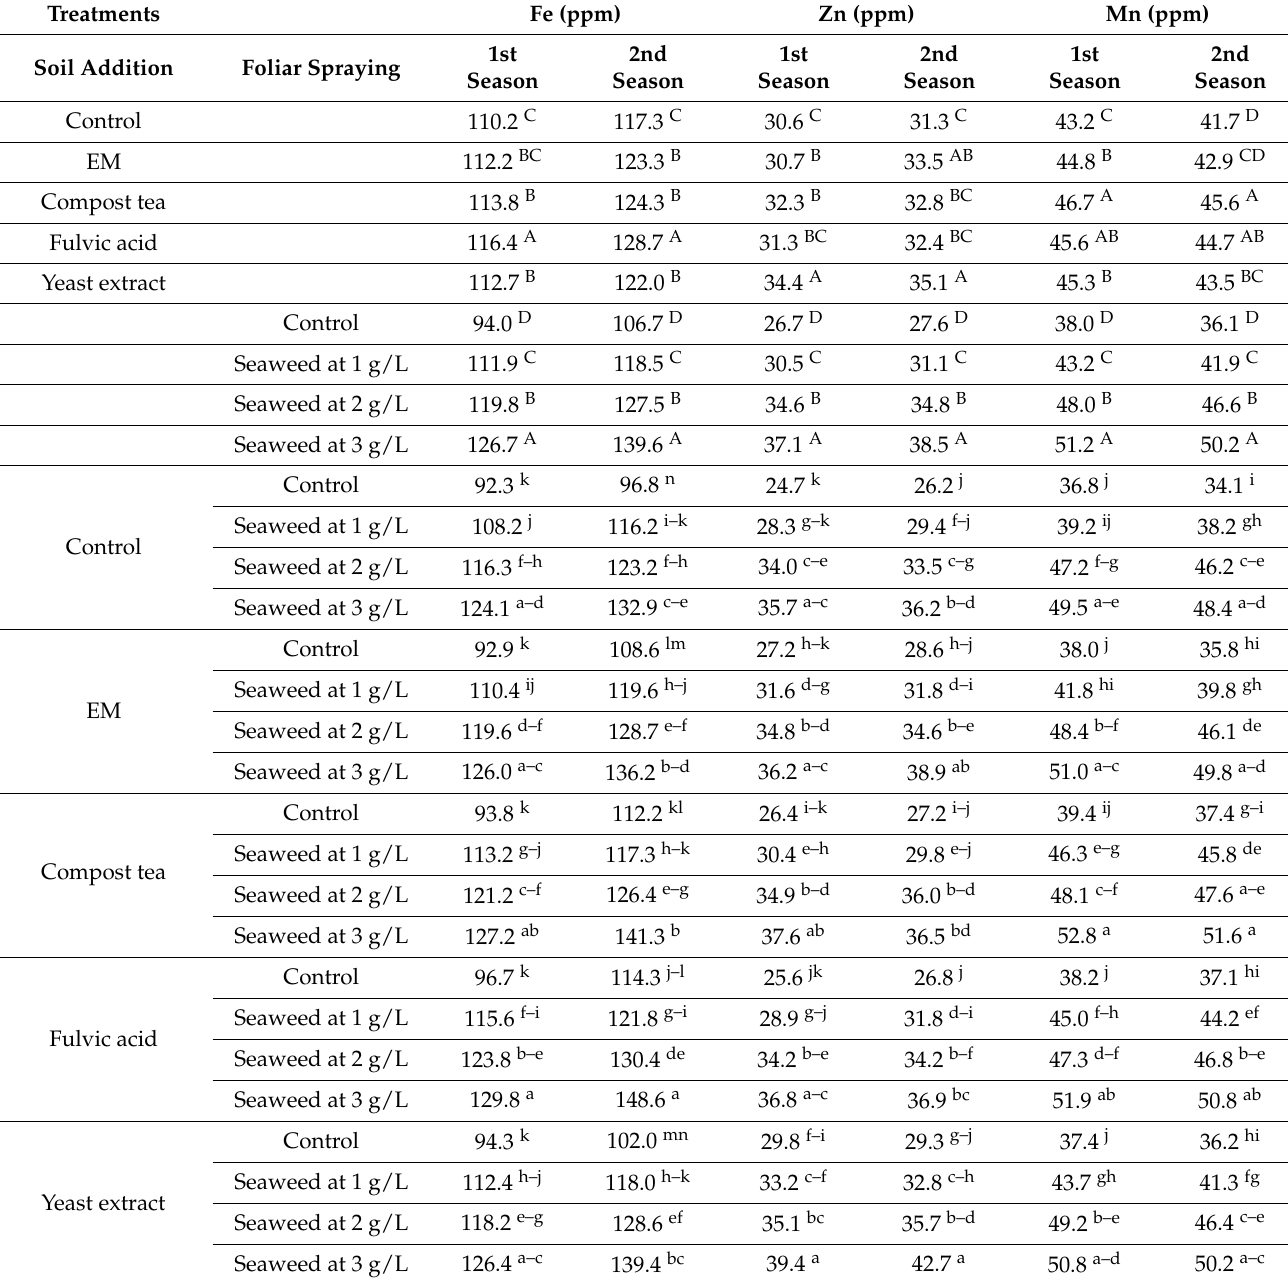
Table 3. Effects of the soil addition of EM, compost tea, fulvic acid, yeast extract, and foliar spray with seaweed extract and their combinations on the micronutrients content of the plant foliage of sweet pepper plants during the 2019/2020 and